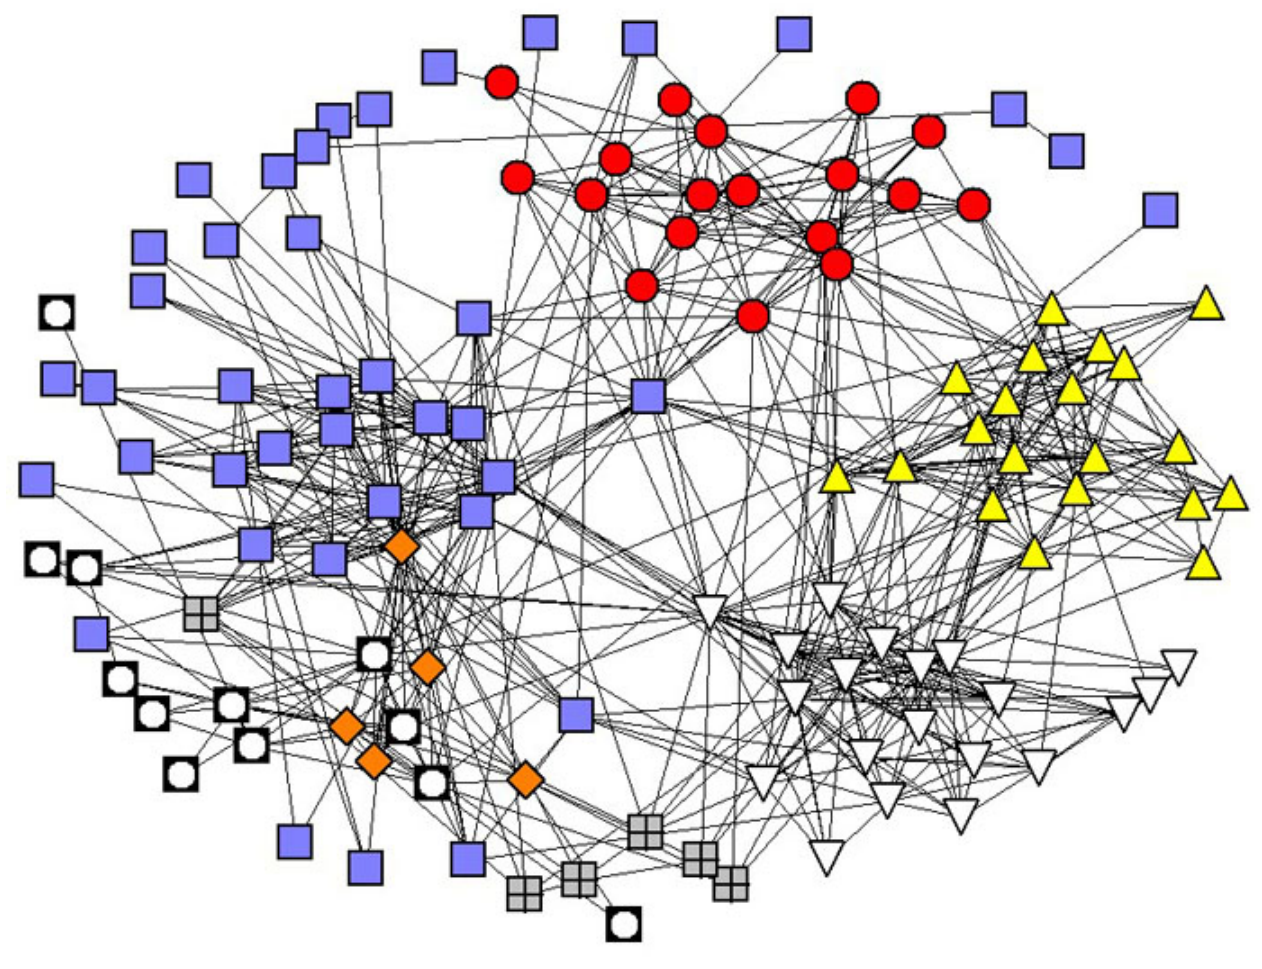
Fig. 4. Multi-dimensional scaling plot showing the network structure of 121 fishers. The position of each fisher is estimated based on both within-community and between-community ties, and fishers’ community affiliation is shown with different shapes and colors. Agua Verde (red circle), Colonia Zaragoza (purple square), Ensenada Blanca (yellow upright triangle), Juncalito (gray box), Ligüí(white downward triangle), San Nicolás (white circle-in-box), and Ramadita (orange